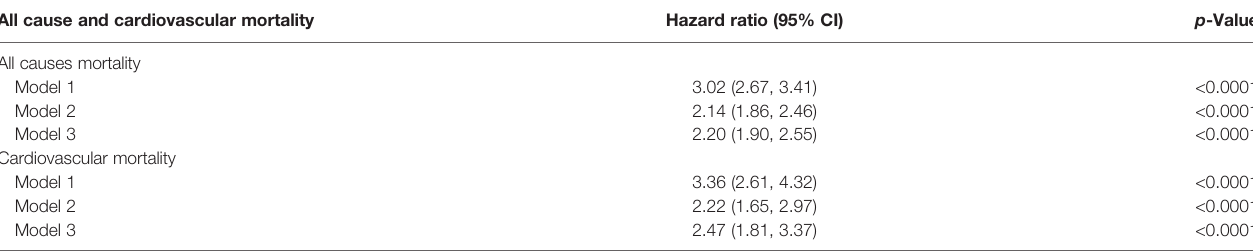
TABLE 2 | Hazard ratio for all-cause mortality and cardiovascular mortality by Cox proportional hazards models. All cause and cardiovascular mortality Hazard ratio (95% CI) p -Value All causes mortality Model